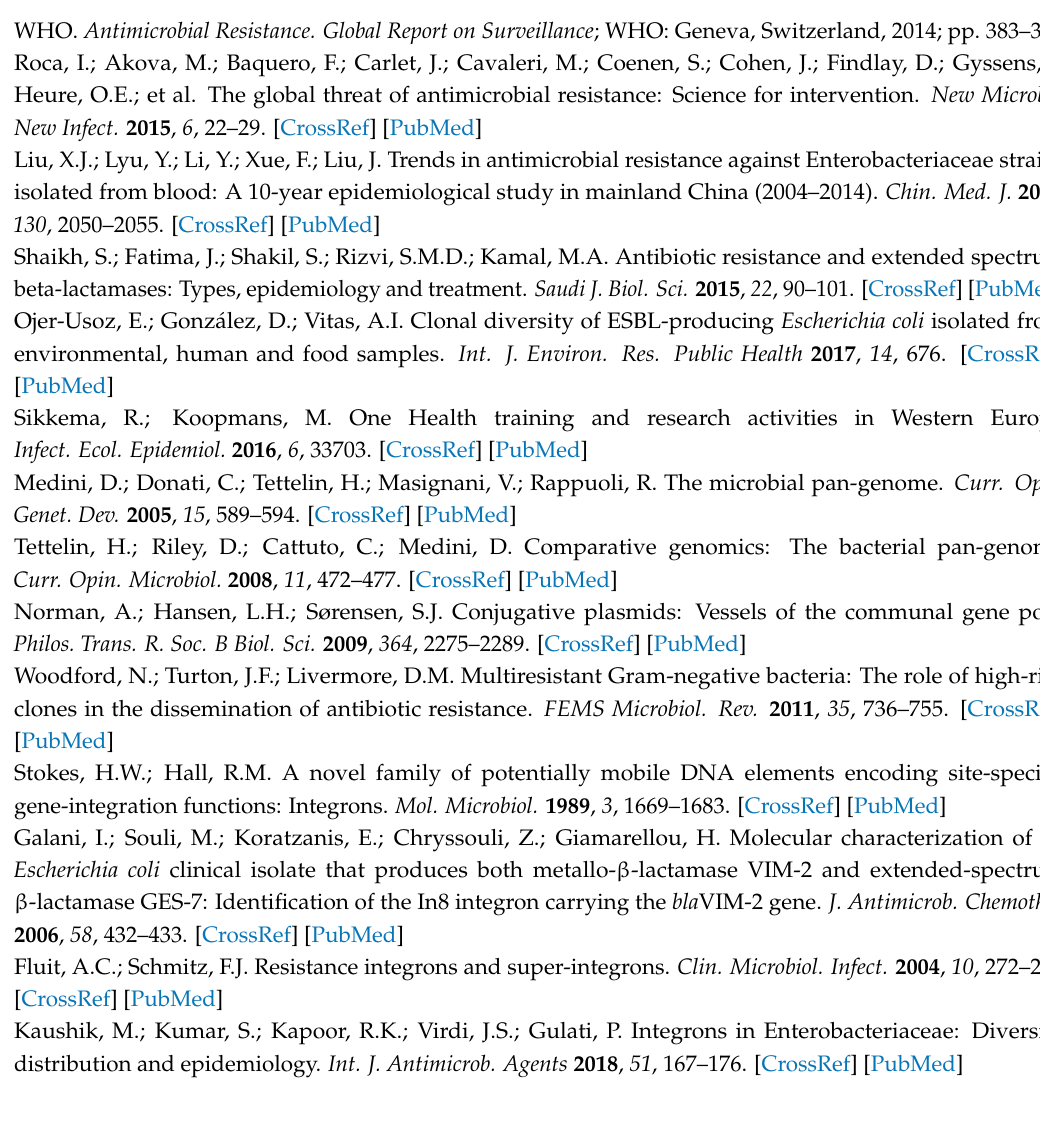
Supplementary Materials: Table S1: Antimicrobial profiles of ESBL-producing E. coli according to their origin; Table S2: Phenotypic and genotypic characteristics of strains isolated from hospital inpatients ( n = 36); Table S3: Phenotypic and genotypic characteristics of aquatic strains included in the study ( n = 33); Table S4: Phenotypic and genotypic characteristics of strains isolated from food ( n = 48); Table S5: Phenotypic and genotypic characteristics of strains from farm origin included in the study ( n = 20); Table S6: Phenotypic and genotypic characteristics of strains isolated from healthy people ( n =